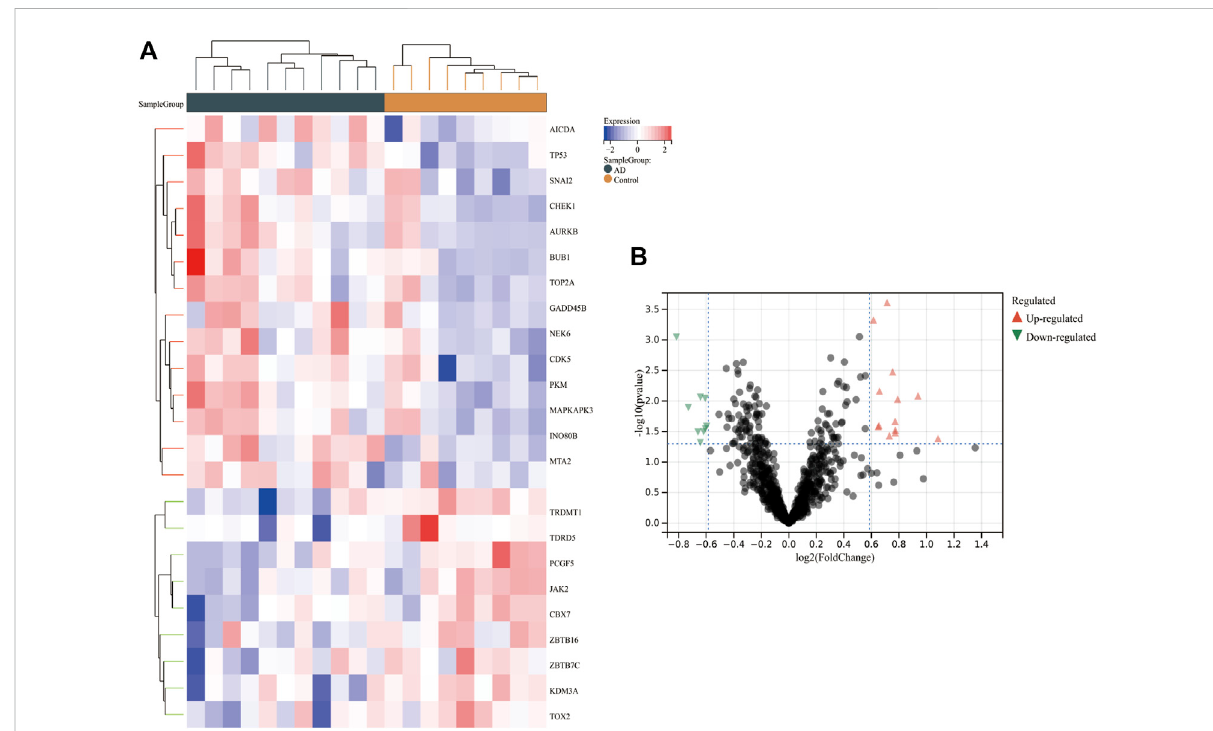
FIGURE 2 Heatmap and volcano plot of DECRs in AD. (A) The heatmap reveals signi fi cant DECRs between the AD group and control group. Red and blue blocksdepictDECRswithupregulatedexpressionanddownregulatedexpression,respectively.DECRsandeachsamplearerepresentedbyrowsand columns. (B) The volcano plot displays all DECRs. Red and green triangles re fl ect DECRs with signi fi cantly upregulated and downregulated expression, respectively. AbbreviationsDECRs, differentially expressed chromatin regulators; AD, aortic